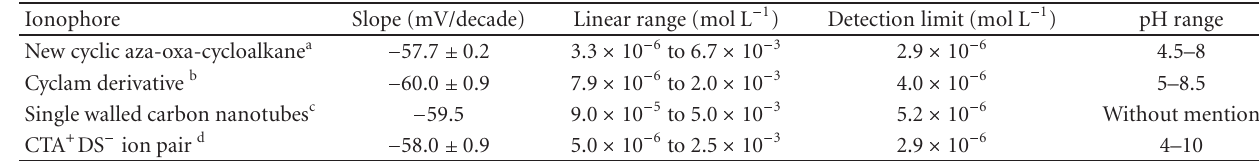
Table 6: Comparison table with previously similar reported